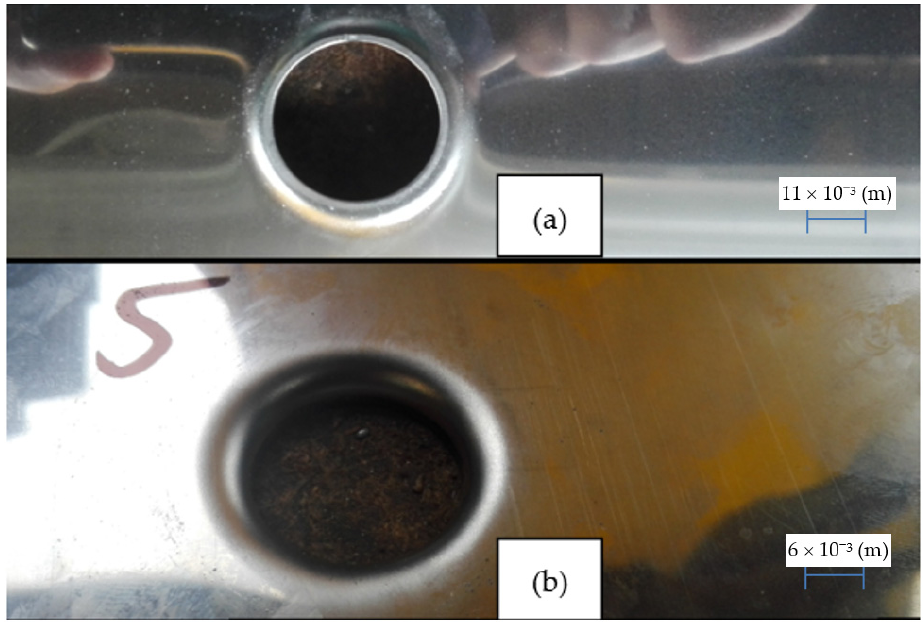
Figure 16. Example research sample after the flange extrusion process for the h6 model: view from above ( a ), internal surface ( b ).